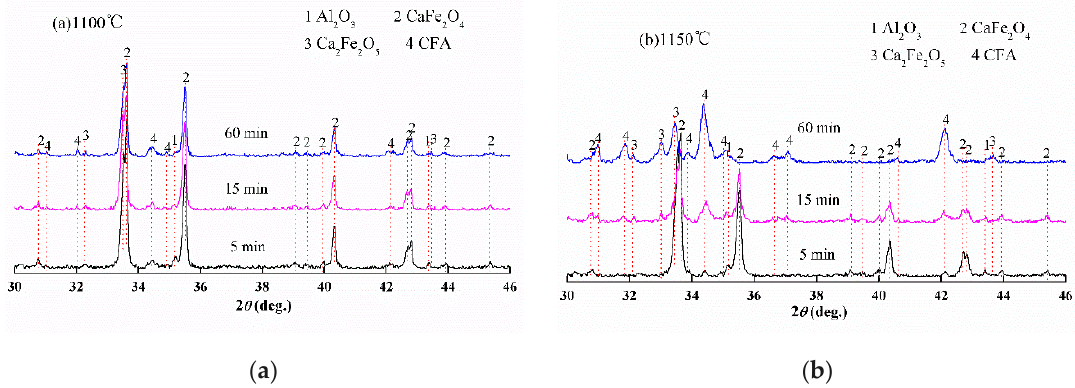
Figure 2. XRD patterns of the reaction products between Al 2 O 3 and CF sintered at 1100 °C ( a ) and 1150 °C ( b ) for 5 min, 15 min and 60 min respectively.